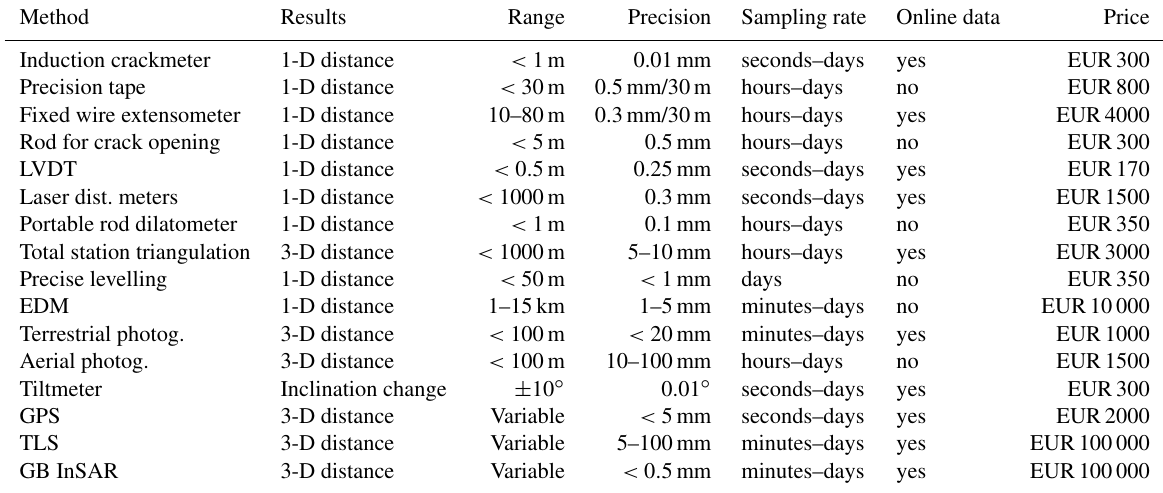
Table 2. A comparison of rock slope spatial change monitoring techniques (updated after Klimeš et al., 2012). LVDT stands for linear variable differential transformer, EDM stands for electronic distance measurement, and GB InSAR stands for ground-based interferometric synthetic aperture